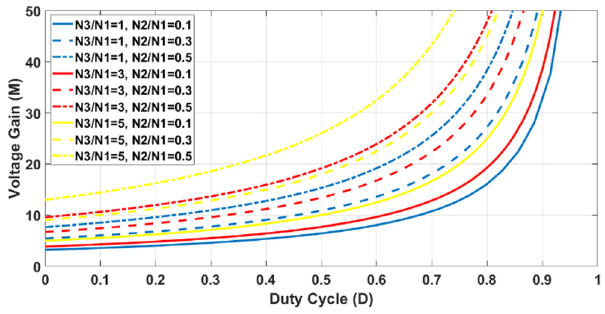
Figure 4. The schematic diagram of the three-winding coupled inductor.